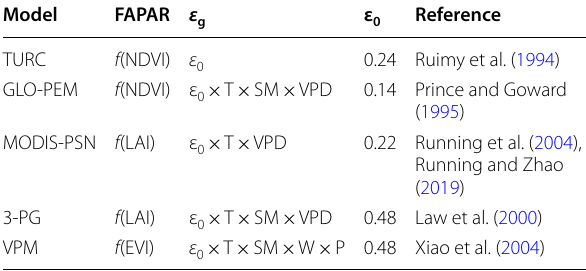
Table 3 Comparison of light-use efficiency models for gross primary production